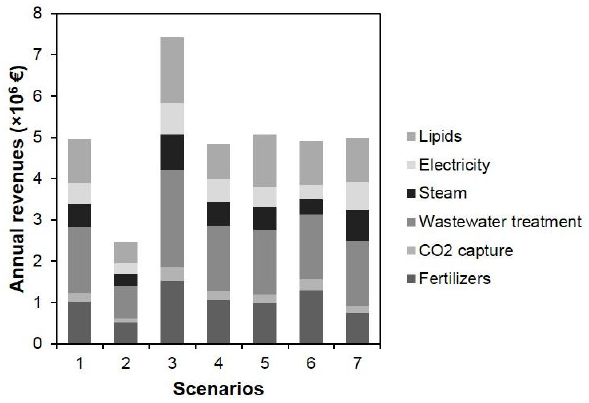
Figure 4. Annual revenues obtained in each of the studied scenarios.